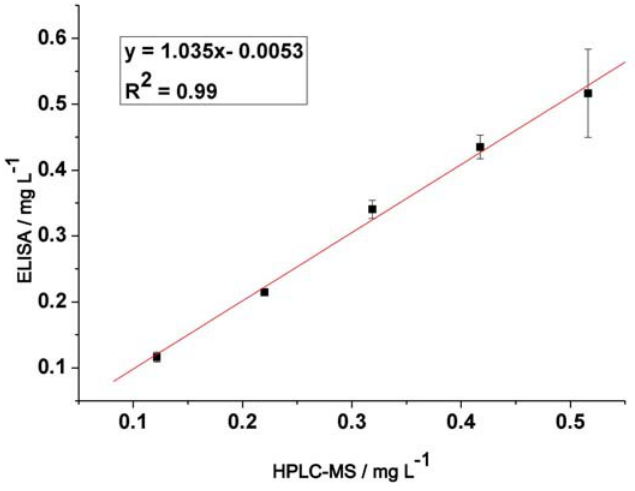
Figure 5. Correlation of icELISA with HPLC-MS analysis for milk samples (n =